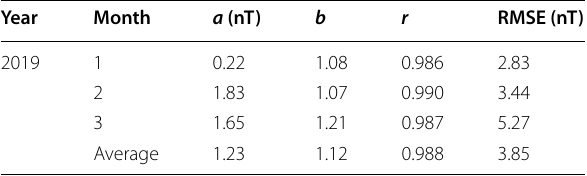
Table 4 Linear fitting coefficients and correlation between the prediction of the daily variation and the magnetic field